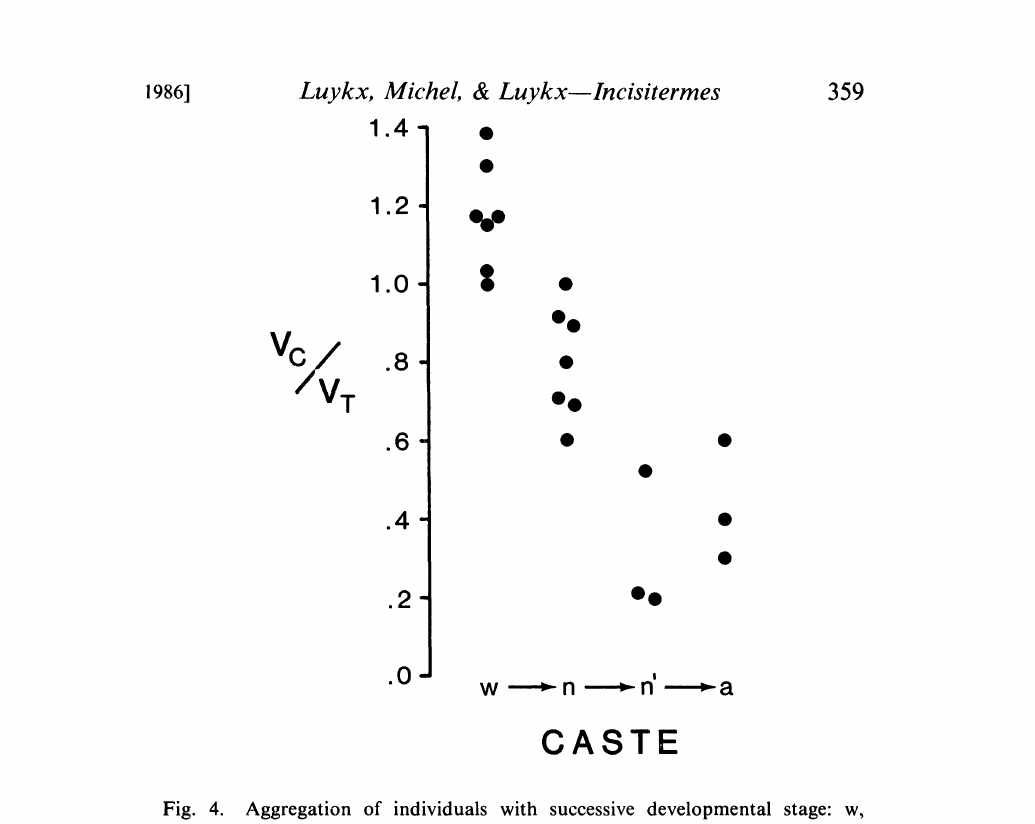
Fig. 4. Aggregation of individuals with successive developmental stage: w, workers; n, early-stage nymphs; n’, late-stage nymphs; a, alates (imagos). Vc/VT, ratio of position-variance of members of a given caste to position-variance of all castes in the colony taken